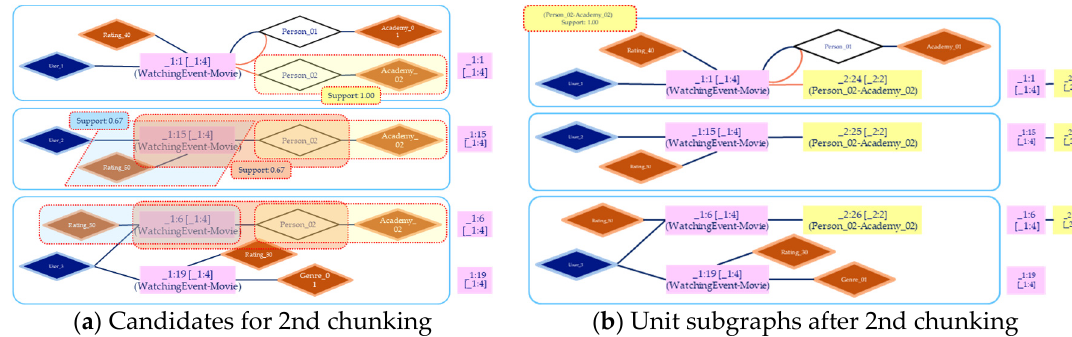
Figure 13. 2nd candidate generation and chunking result.